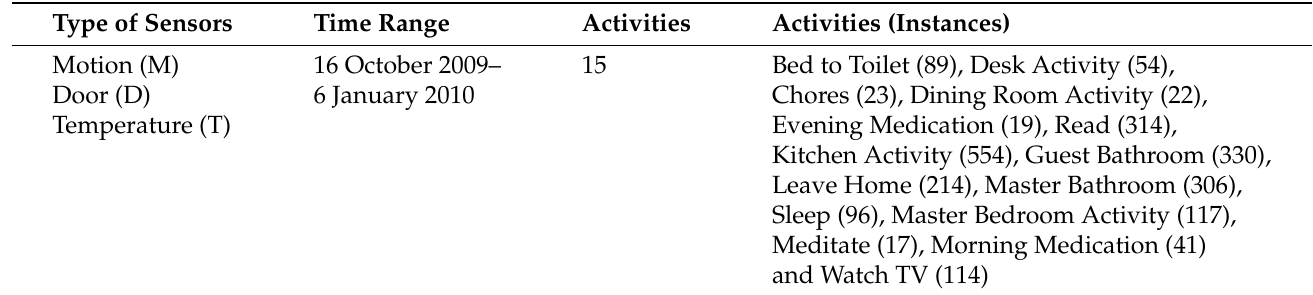
Table 1. Milan dataset main features.